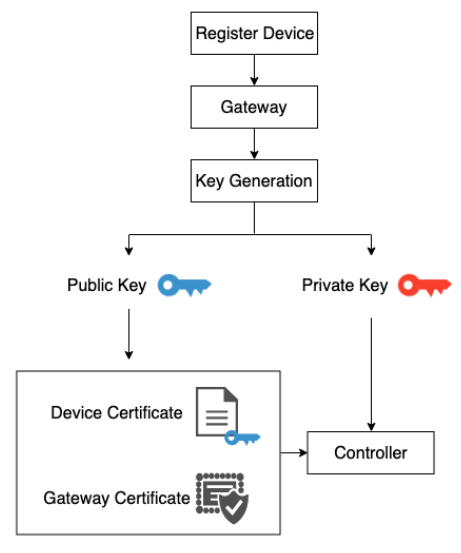
Figure 3. The flowchart of device registration.